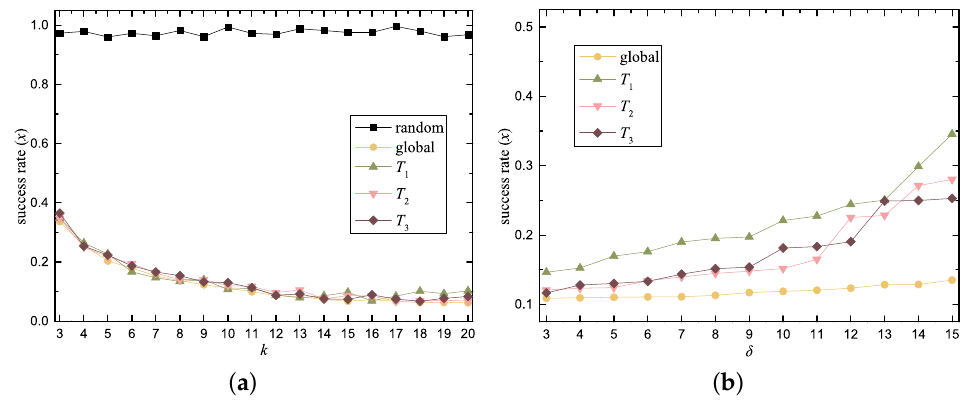
Figure 6. Experiment results of resistance to direct observation attack. ( a ) x vs. k with a fixed δ of 5; ( b ) x vs. δ with a fixed k of